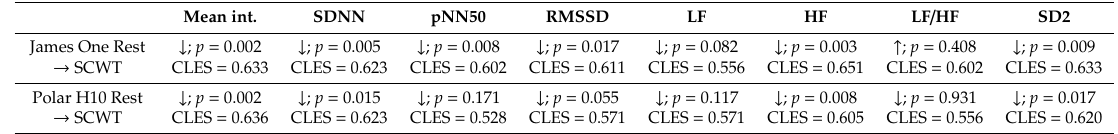
Table 5. Comparison of the HRV metrics obtained during the resting stage and the SCWT. A ↓ indicates a decrease in the HRV metrics and ↑ an increase. A p -value lower than 0.05 indicates that the di ff erences between the rest and the SCTW were significant. The e ff ect size is reported as CLES. Mean int. SDNN pNN50 RMSSD LF HF LF / HF SD2 ↓ ; p = 0.002 ↓ ; p = 0.005 ↓ ; p = 0.008 ↓ ; p = 0.017 ↓ ; p = 0.082 James One Rest → SCWT CLES = 0.633 CLES = 0.623 CLES = 0.602 CLES = 0.611 CLES =